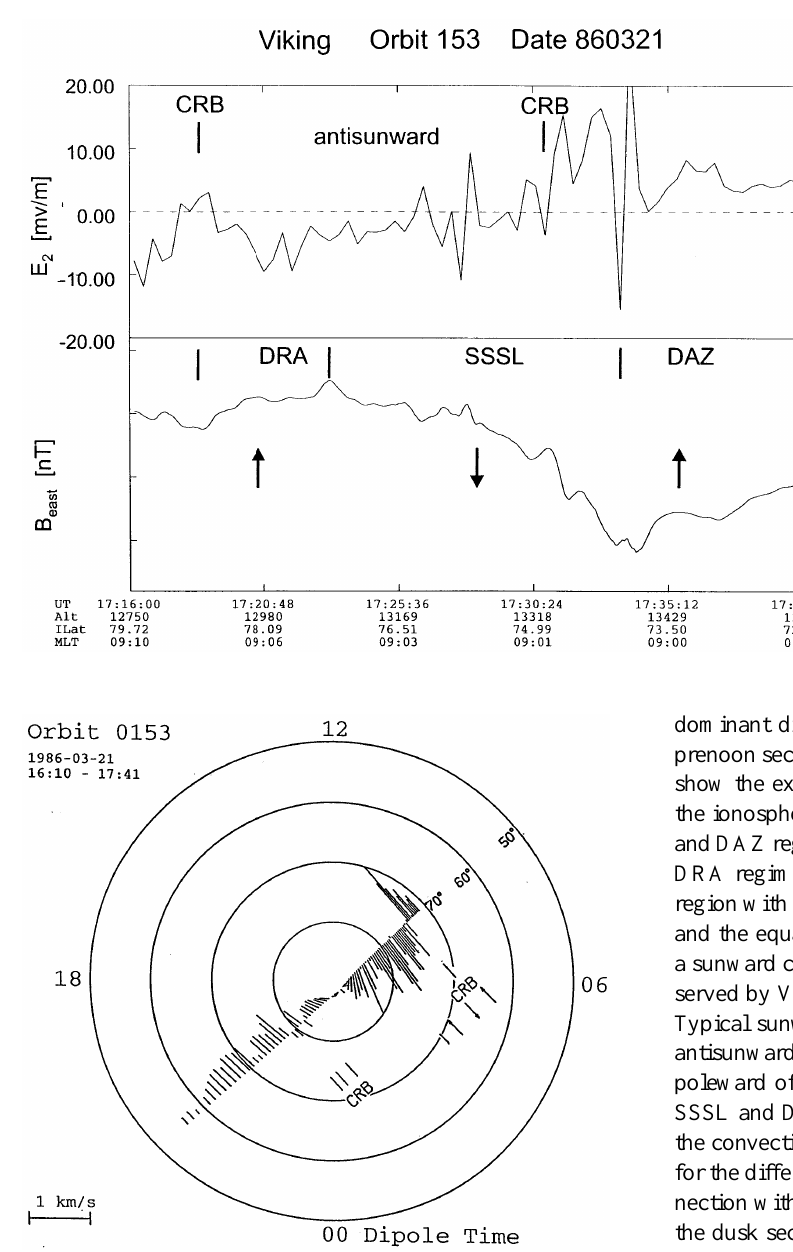
Fig. 14. The same as Fig. 8, except for 21 March 1986, 1610–1741